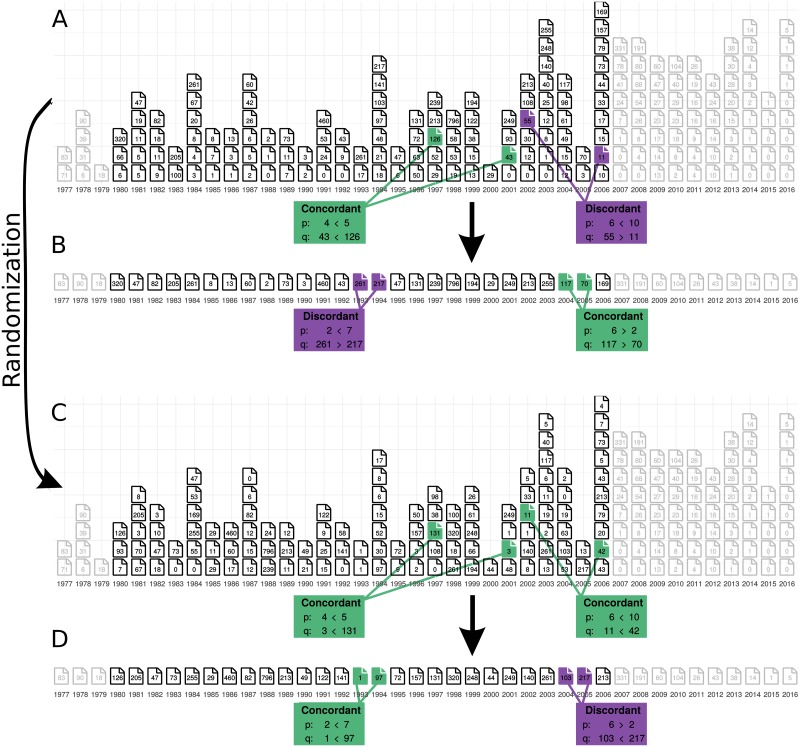
Sketch of the analysis.A scientist’s publication record can be depicted by the number of papers published each year and the number of citations each paper has accrued. Our analysis is restricted to those papers published between 1980 and 2006. To evaluate whether or not a scientist experiences a trade-off between quantity (the number of papers published in a given year, indicated by the number of stacked pages) and quality (shown here as the number of citations accrued by those papers for simplicity, and indicated by the number within each page icon), we take each pair of papers and compare the number of papers published in the same year with the number of citations each paper has (A). If the lower cited paper comes from the year with fewer publications, then we call the pair concordant, else we call it discordant. we then look at the number of pairs falling into each category and calculate a correlation coefficient (Eq 1). To reduce potential biases introduced by considering all possible pairings, we can select a summary statistic and only consider pairs of this statistic between adjacent years, e.g. the maximally-cited paper in each year (B). To get an understanding of our expectations for the number of concordant versus discordant pairs, we can take an empirical time-line and randomize the citation counts among an author’s publications and re-run the analysis (C-D). Note that choosing the same pairs in a randomized timeline can result in the same or different relationships between the p’s and q’s. For each author, we are interested in the proportion of all possible pairings that are concordant. Proportions less than 0.5 correspond to a τ less than 0 and are indicative of a trade-off between quantity and quality.